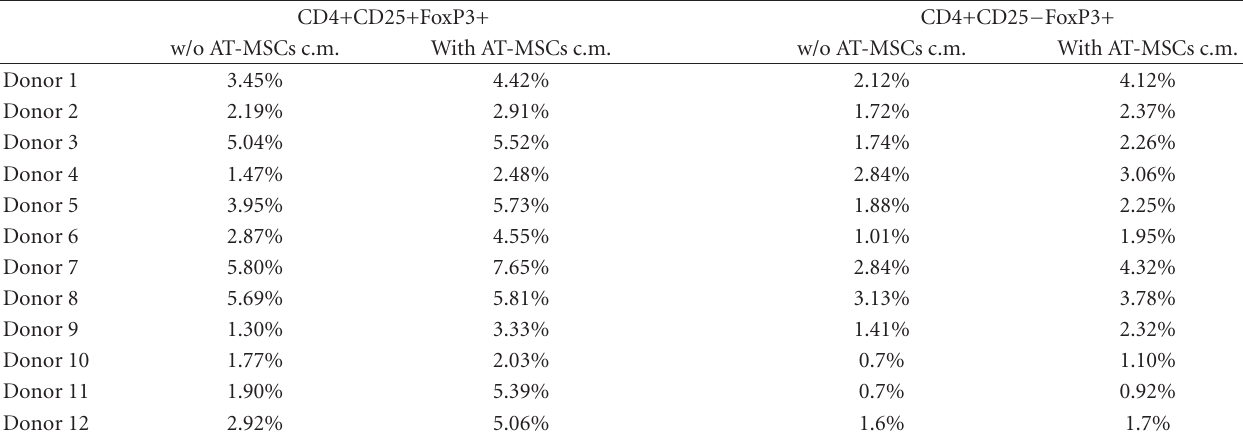
Table 1: The e ff ect of AT-MSCs conditioned medium on the percentage values of CD4+FoxP3+ T lymphocytes in cultures of T helper cells obtained from di ff erent donors. The data from all subjects tested revealed the stable tendency towards an increase of CD4+CD25+FoxP3+ and CD4+CD25 − FoxP3+ cell numbers in the presence of AT-MSCs conditioned medium compared with the respective control cultures. CD4+CD25+FoxP3+ CD4+CD25 − FoxP3+ w/o AT-MSCs c.m. With AT-MSCs c.m. w/o AT-MSCs c.m. With AT-MSCs c.m.